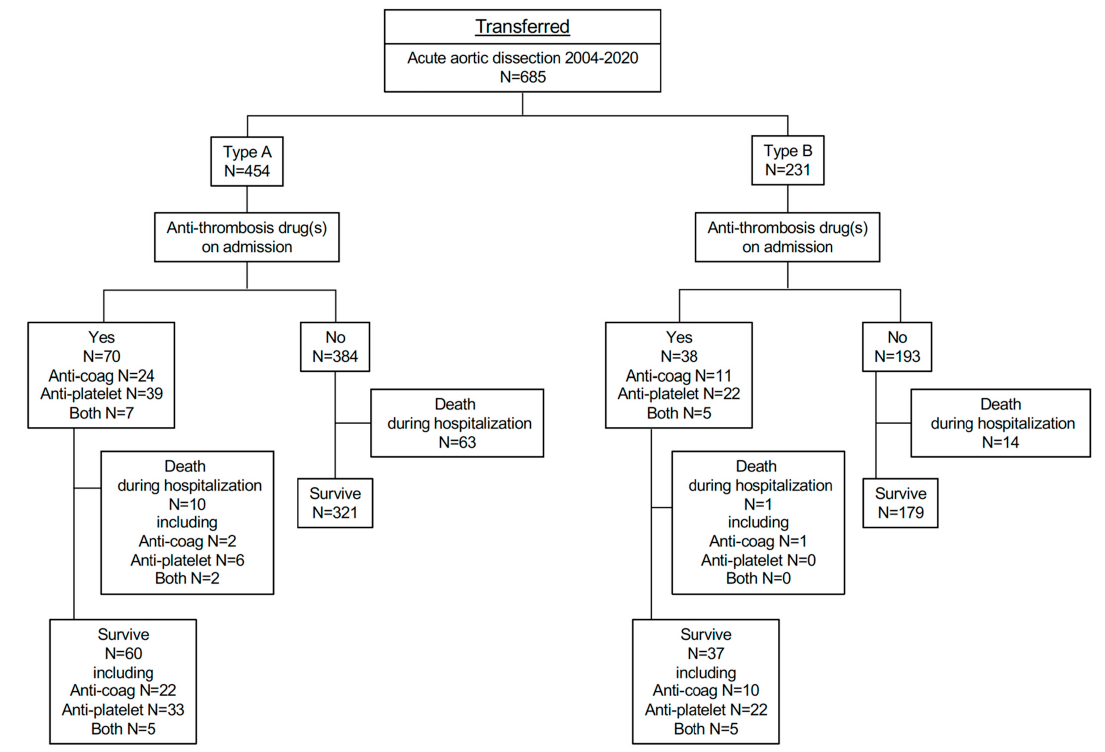
Table 1. Clinical characteristics of TRANSFERRED acute aortic dissection patients with and without anti-thrombotic therapy. Stanford Type A (n = 454)